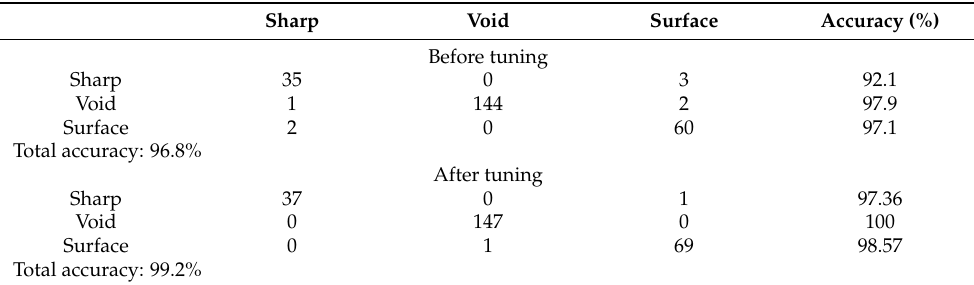
Figure 10. Accuracy comparison plot for different threshold value. Table 9. Classification accuracy before and after hyper parameter